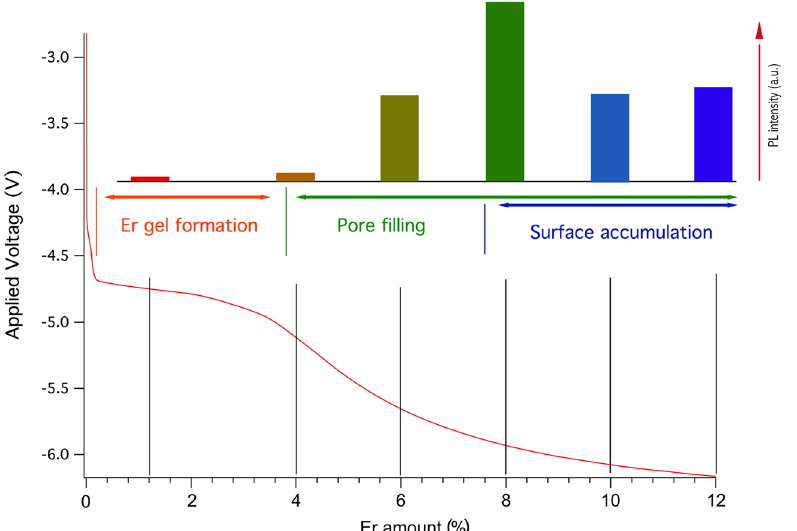
Figure 6. Comparison of the data from the EI and PL as a function of the Er content. The black lines under the PL intensities indicate the amount’s evolution of Er for that sample (the conversion from EI duration and Er content is reported in Table 1). The colored thin vertical lines are drawn to give an approximate indication of where the different EI phases described are present during an EI process. The PL intensities are taken from the Er PL emission data shown in Fig. 2(A) and the EI curve is that reported in Fig.